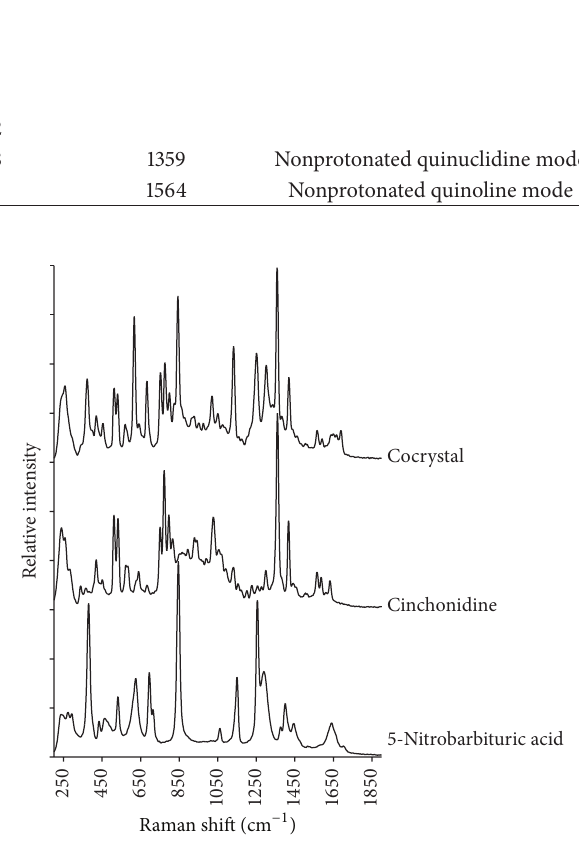
Figure 6: X-ray powder diffraction patterns of 5-nitrobarbituric acid,cinchonidine,andthe1 :1nitrobarbituric-cinchonidinecocrys- tal.